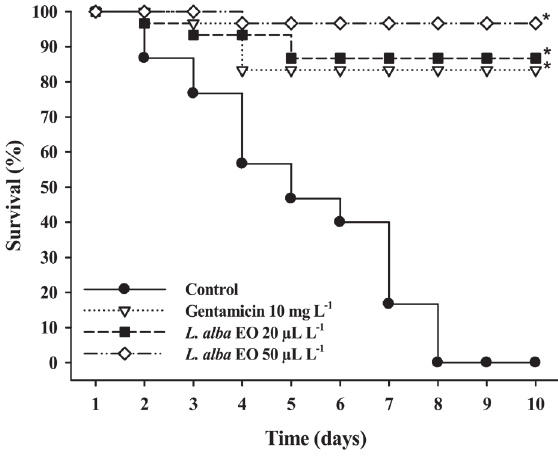
Figure 1 - Survival of juvenile silver catfish infected with Aeromonas sp. and treated with L. alba EO. (*) indicates significant difference relative to negative control. Kaplan- Meier survival analysis with Logrank test ( P <